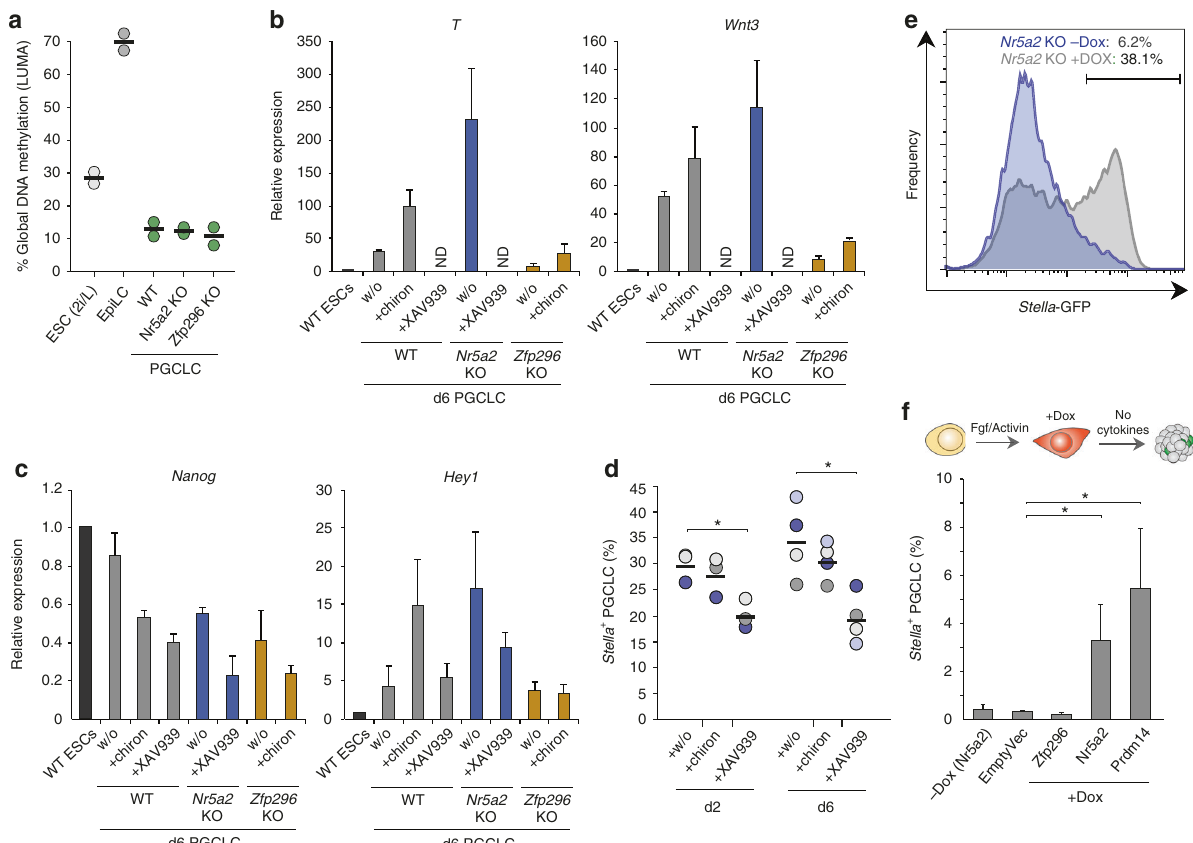
Fig. 6 Role of WNT and rescue of Nr5a2 defects. a Global levels of DNA methylation reprogramming in WT and mutant PGCLC assayed by LUMA. b qRT- PCR analysis showing expression of WNT genes/targets are affected by WNT inhibitor ( + XAV939) or agonist ( + chiron), similarly to knockout PGCLC. w/ o: control without WNT modulation. c Expression of Nanog and mesendoderm gene Hey1 by qRT-PCR in WT and mutant PGCLC with WNT modulation. d Effects of WNT manipulation on ef fi ciency of PGCLC ontogeny in quadruplicate independent experiments. Bar indicates mean value and * p < 0.05. e FACS plot showing the Nr5a2 -mutant PGCLC speci fi cation defect at d2 is rescued by Dox-inducible activation of exogenous Nr5a2 cDNA. Dox is added after EpiLC induction. f Percentage Stella + PGCLC induced without cytokines from WT cells upon DOX-inducible expression of the indicated